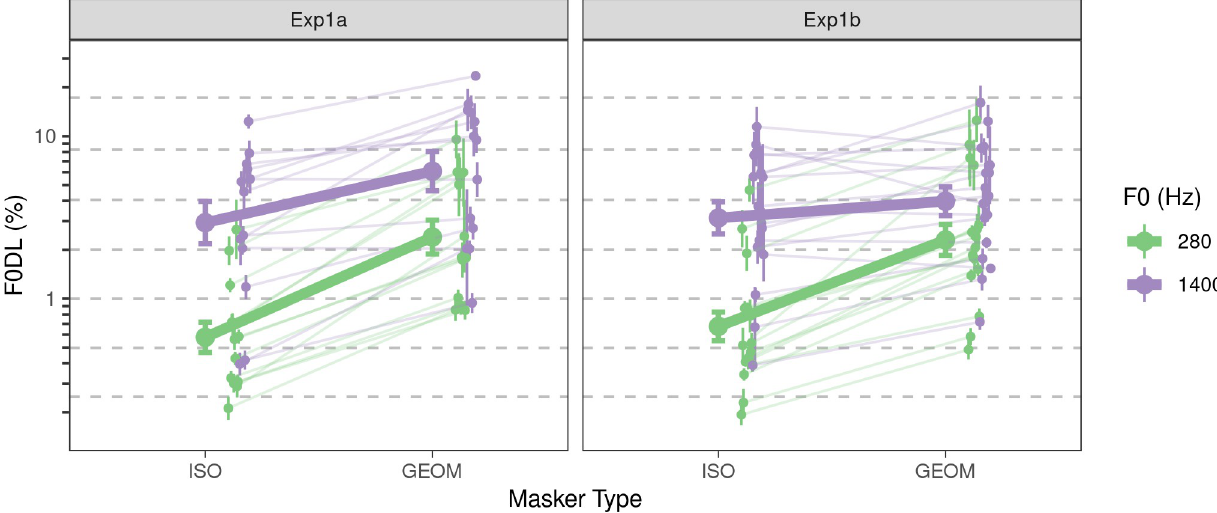
Fig 2. Behavioral results from Experiment 1. The left panel (Exp1a) shows results with only harmonics 6–10 present in the target; the right panel (Exp1b) shows results with the bandpass filtered target, with harmonics 6–10 in the passband. Large filled circles and error bars indicate the average F0DL and ± 1 standard error of the mean (SEM). The small filled circles and error bars indicate individual F0DLs and ± 1 SEM for each participant.